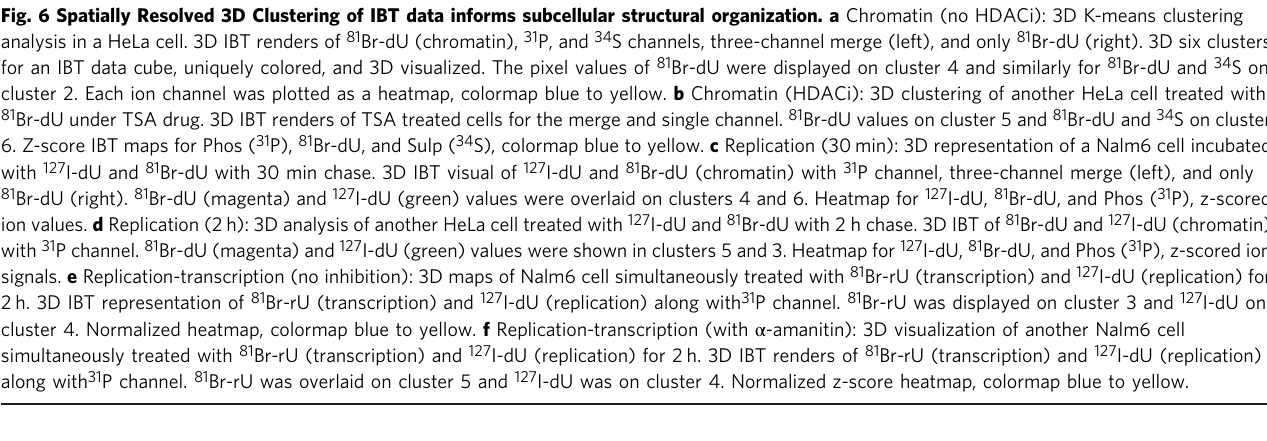
Fig. 6 Spatially Resolved 3D Clustering of IBT data informs subcellular structural organization. a Chromatin (no HDACi): 3D K-means clustering analysis in a HeLa cell. 3D IBT renders of 81 Br-dU (chromatin), 31 P, and 34 S channels, three-channel merge (left), and only 81 Br-dU (right). 3D six clusters for an IBT data cube, uniquely colored, and 3D visualized. The pixel values of 81 Br-dU were displayed on cluster 4 and similarly for 81 Br-dU and 34 S on cluster 2. Each ion channel was plotted as a heatmap, colormap blue to yellow. b Chromatin (HDACi): 3D clustering of another HeLa cell treated with 81 Br-dU under TSA drug. 3D IBT renders of TSA treated cells for the merge and single channel. 81 Br-dU values on cluster 5 and 81 Br-dU and 34 S on cluster 6. Z-score IBT maps for Phos ( 31 P), 81 Br-dU, and Sulp ( 34 S), colormap blue to yellow. c Replication (30 min): 3D representation of a Nalm6 cell incubated with 127 I-dU and 81 Br-dU with 30 min chase. 3D IBT visual of 127 I-dU and 81 Br-dU (chromatin) with 31 P channel, three-channel merge (left), and only 81 Br-dU (right). 81 Br-dU (magenta) and 127 I-dU (green) values were overlaid on clusters 4 and 6. Heatmap for 127 I-dU, 81 Br-dU, and Phos ( 31 P), z-scored ion values. d Replication (2 h): 3D analysis of another HeLa cell treated with 127 I-dU and 81 Br-dU with 2 h chase. 3D IBT of 81 Br-dU and 127 I-dU (chromatin) with 31 P channel. 81 Br-dU (magenta) and 127 I-dU (green) values were shown in clusters 5 and 3. Heatmap for 127 I-dU, 81 Br-dU, and Phos ( 31 P), z-scored ion signals. e Replication-transcription (no inhibition): 3D maps of Nalm6 cell simultaneously treated with 81 Br-rU (transcription) and 127 I-dU (replication) for 2 h. 3D IBT representation of 81 Br-rU (transcription) and 127 I-dU (replication) along with 31 P channel. 81 Br-rU was displayed on cluster 3 and 127 I-dU on cluster 4. Normalized heatmap, colormap blue to yellow. f Replication-transcription (with α -amanitin): 3D visualization of another Nalm6 cell simultaneously treated with 81 Br-rU (transcription) and 127 I-dU (replication) for 2 h. 3D IBT renders of 81 Br-rU (transcription) and 127 I-dU (replication) along with 31 P channel. 81 Br-rU was overlaid on cluster 5 and 127 I-dU was on cluster 4. Normalized z-score heatmap, colormap blue